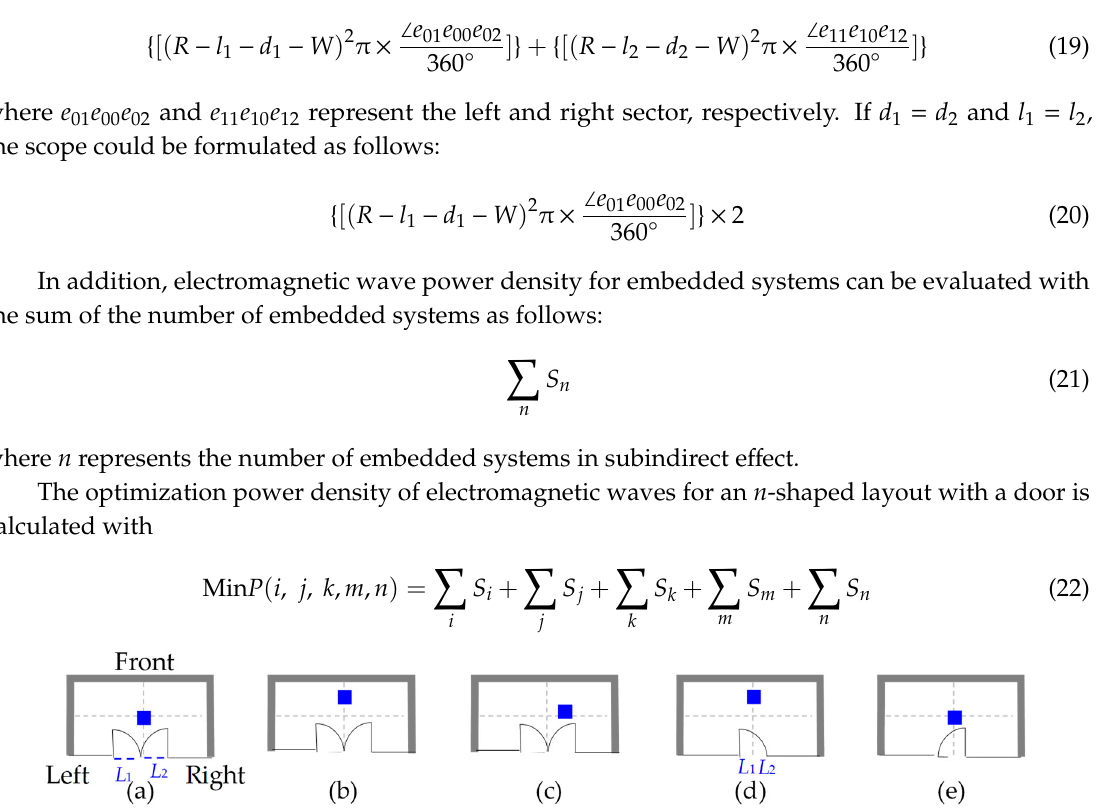
Figure 9. n -shaped layout with a door. ( a ) Radiation of power density distribution. ( b ) Local, ( c ) direct, ( d ) semidirect, ( e ) indirect, and ( f ) subindirect effects. 4. Experiment Results Figure 3 illustrates the smart office with business, work, and meeting room areas where a communication center C and 16 embedded systems S 0 , S 1 , …, and S 1 5 were set up. We implemented